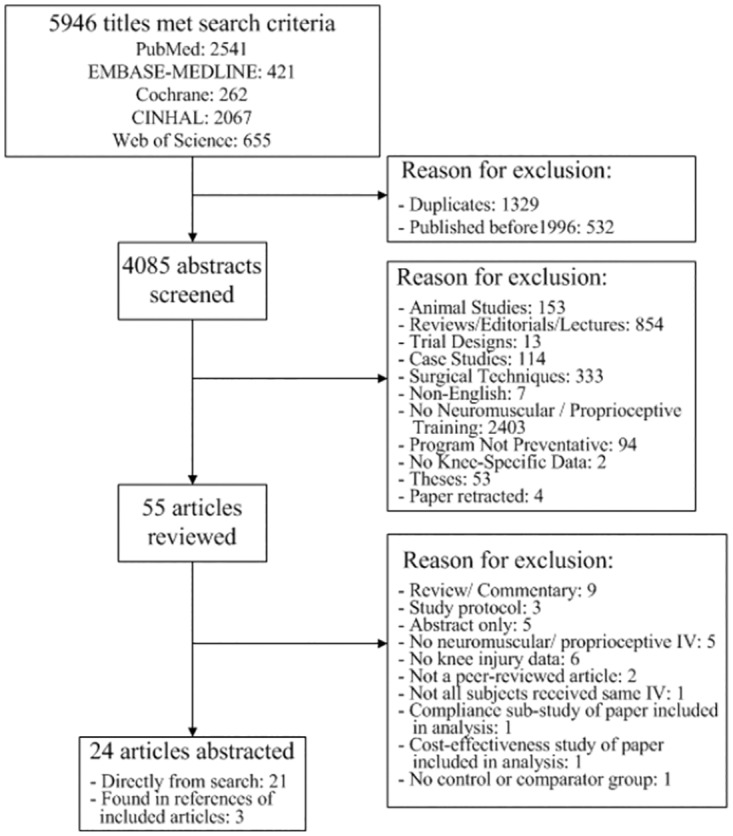
PRISMA Flow Diagram.